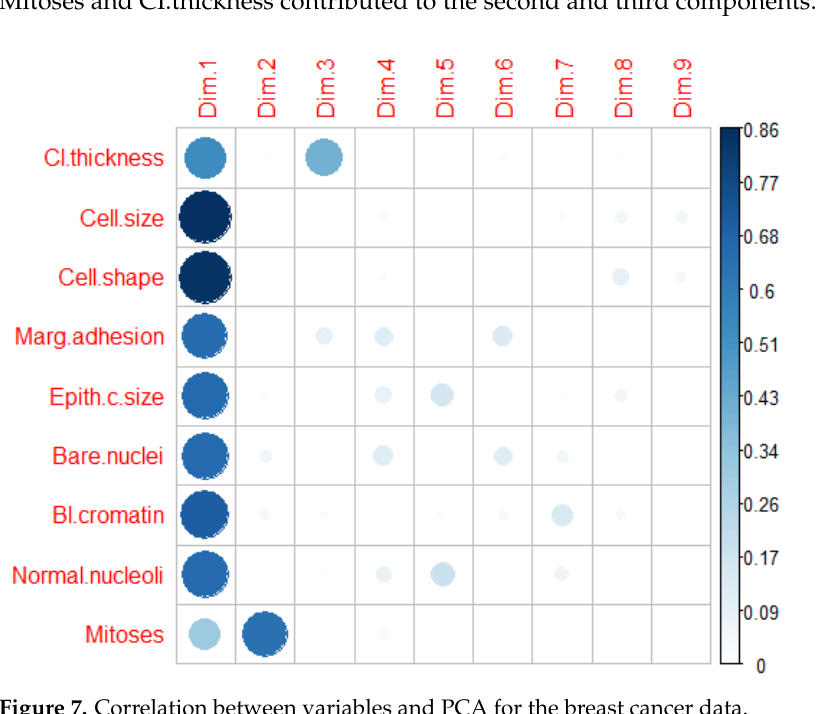
Figure 7. Correlation between variables and PCA for the breast cancer